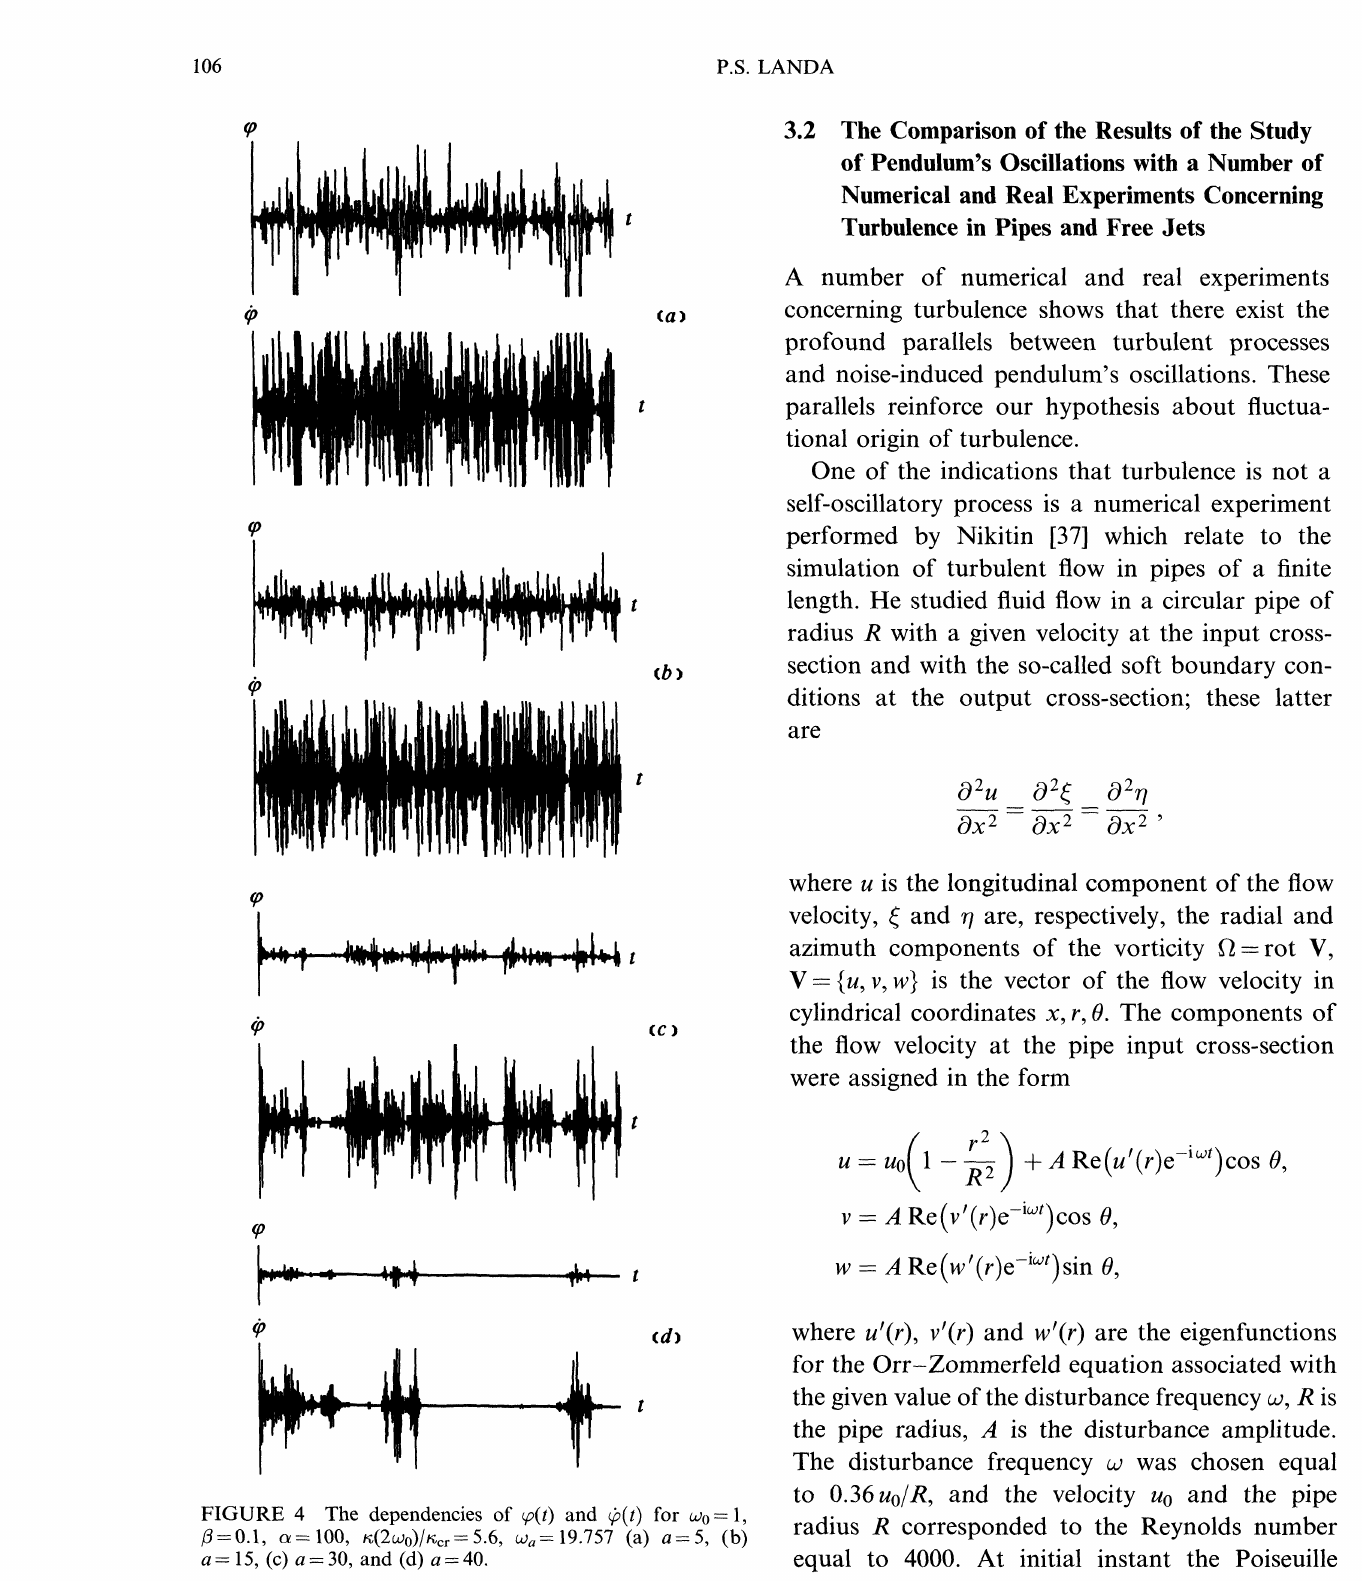
FIGURE 4 The dependencies of :(t) and qb(t) for v0--1, /3--0.1, c---100, (200)/cr---5.6, wa= 19.757 (a) a=5, (b) a 15, (c) a 30, and (d)